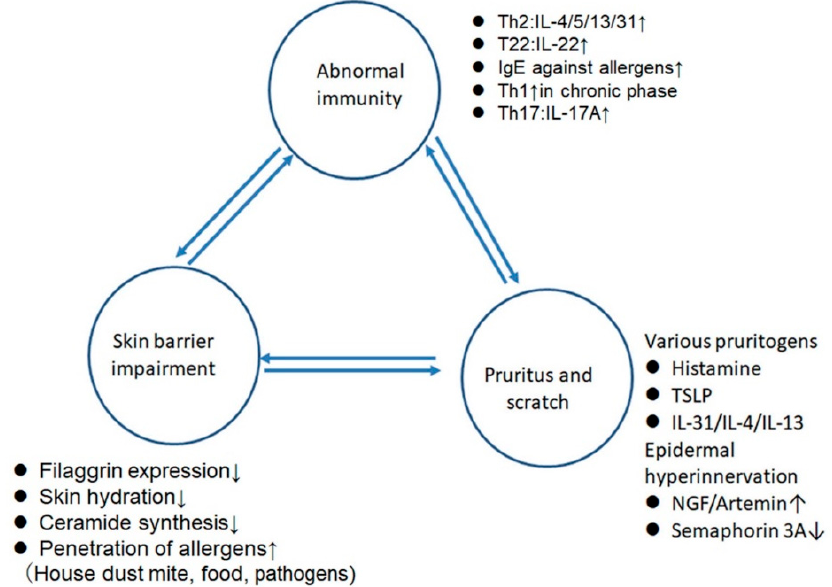
Figure 1. The three elements composing the pathogenesis of atopic dermatitis. Th2, T helper 2 cell; IL-4, interleukin-4; NGF, nerve growth factor; TSLP, thymic stromal lymphopoietin. The prevalence of AD in childhood is slightly higher in boys than in girls: 8.7% and 5.6% for boys and girls, respectively, at <4 years old in the Netherlands [6]. After puberty, there is a slightly higher prevalence of AD in females: 5.7% and 8.1% for men and women, respectively, in Japan [7] or 6.04% and 8.01% in Europe and the USA [8]. This tendency is more remarkable in asthma, another Th2-shifted allergic disease [9]; the female:male percentage of patients was 35:65 at ages of 2 to 13 years, was inversed with 65:35 at ages of 23 to 64 years, are similar between those at ages of 14 to 22 years [10]. Adult female patients with asthma show more severe symptoms than adult male patients; the percentage of hospitalization for symptoms is 68% versus 32% in females versus males [11].